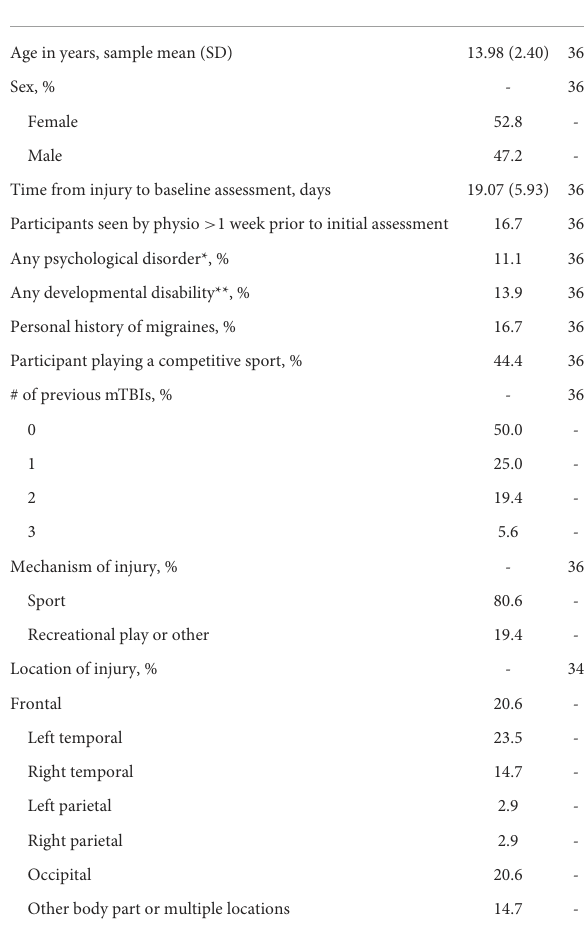
TABLE 2 Descriptive characteristics of